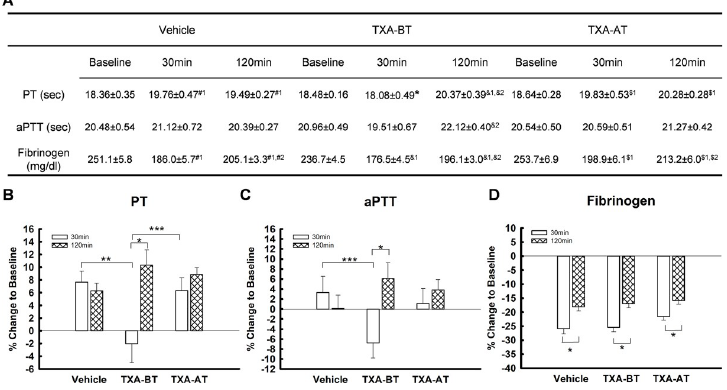
Fig 3. Procoagulant activity (n = 10 per group). (A) Prothrombin time (PT); Activated partial thromboplastic time (aPTT); Fibrinogen. #: Vehicle; &: TXA-BT; $: TXA-AT. # 1 , & 1 and $ 1 : significant difference compared to baseline (BL); # 2 , & 2 and $ 2: significant difference compared to 30min. � : significant difference compared to Vehicle and TXA-AT. (B) to (D): percent change to baseline ((B) PT; (C) aPTT; (D) fibrinogen). � : significant difference between 30min and 120min; �� : significant difference between vehicle and TXA-BT; ��� : significant difference between TXA-BT and TXA-AT. PT and PT% of TXA-BT was significantly lower than that of Vehicle and TXA-AT at 30min. https://doi.org/10.1371/journal.pone.0223406.g003 LI60) among the groups of non-TXA, TXA(S) and TXA(PI). Plasmin at 100 and 250 μ g/ml completely blocked the clot initiation as measured by ROTEM due to expedited fibrinolysis. Pre-incubation of TXA with plasmin (250 μ g/ml) reversed the inhibitory effect of plasmin on clot initiation as compared to plasmin alone (non-TXA) and to plasmin with simultaneously added TXA at the start of assay (TXA-S). However, clotting time (CT) was significantly elon- gated and maximum clot firmness (MCF) was significantly reduced in comparison to baseline (Fig 1C and 1D). Pre-incubation of TXA and plasmin (100 μ g/ml) completely abolished the effect of plasmin on fibrinolysis by reversal of lysis index at 30min and 60min (LI30 and LI60)